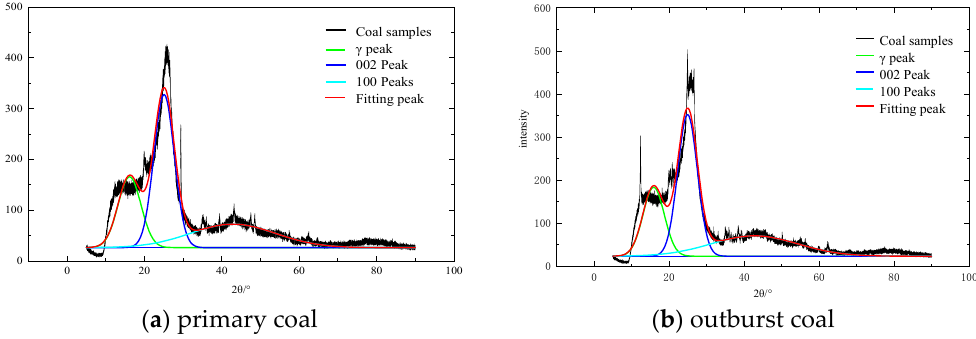
Figure 11. Peak separation fitting results of coal samples.